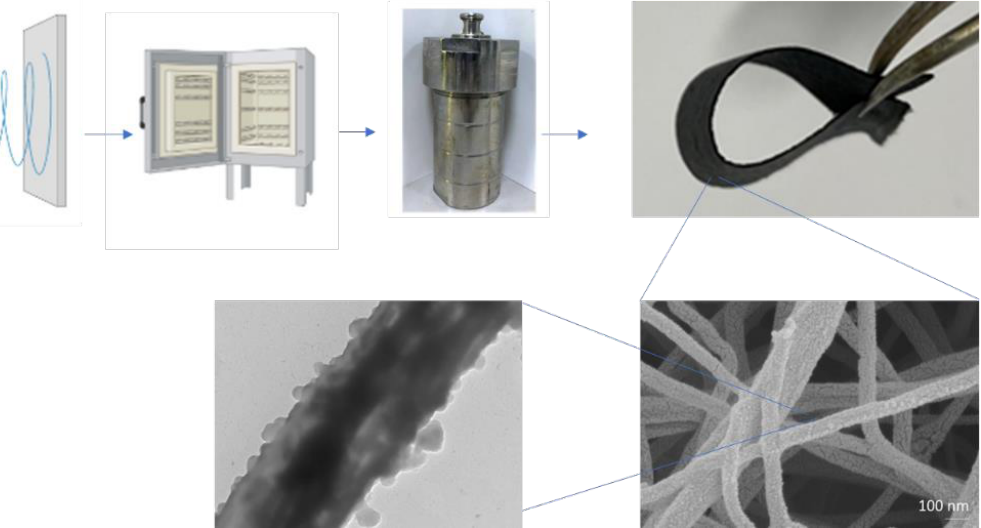
Figure 1. Schematic diagram of the preparation of the flexible MoS 2 @Ge/CNFs.